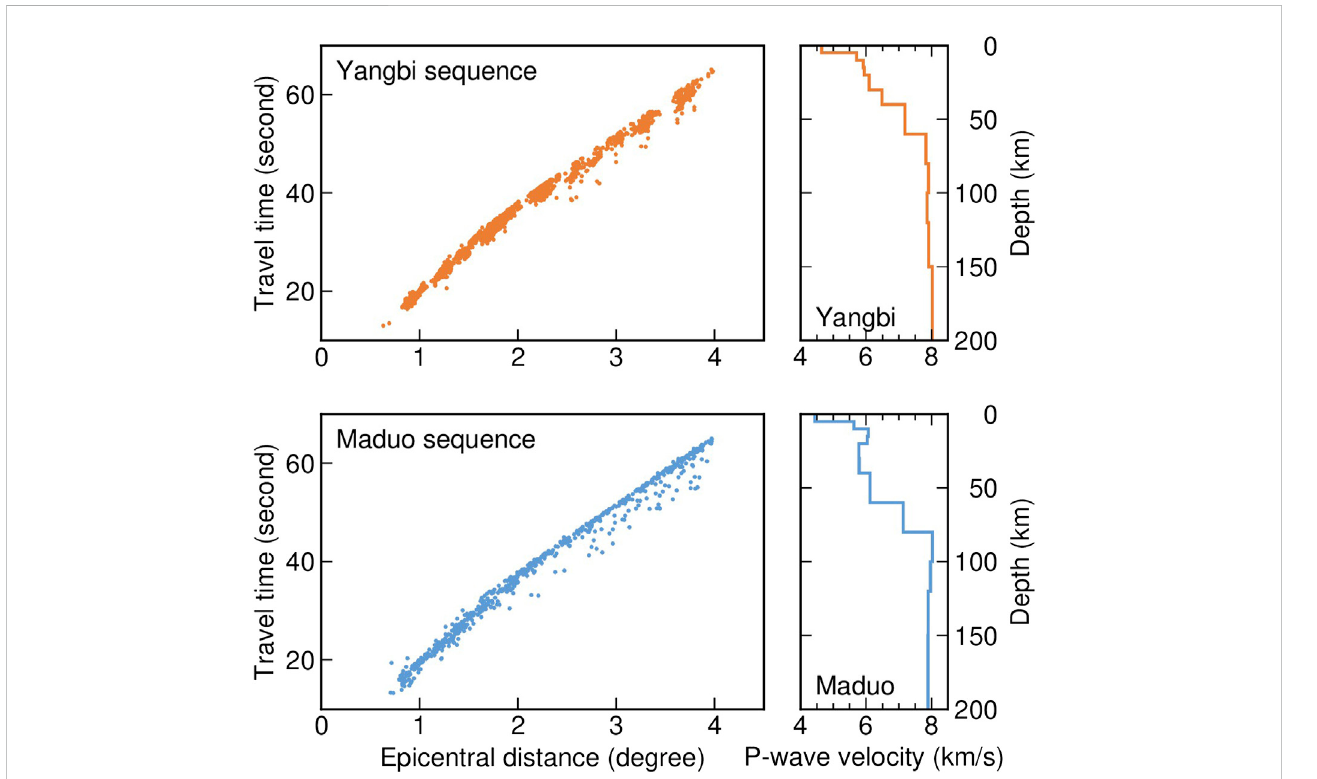
FIGURE 6 Left,traveltimespickedusingthePickNet,andright,theUSTClitho1.01Dvelocitymodelsusedinrelocationcalculations.Theupperandlowerpanelsare for Yangbi and Maduo sequences,